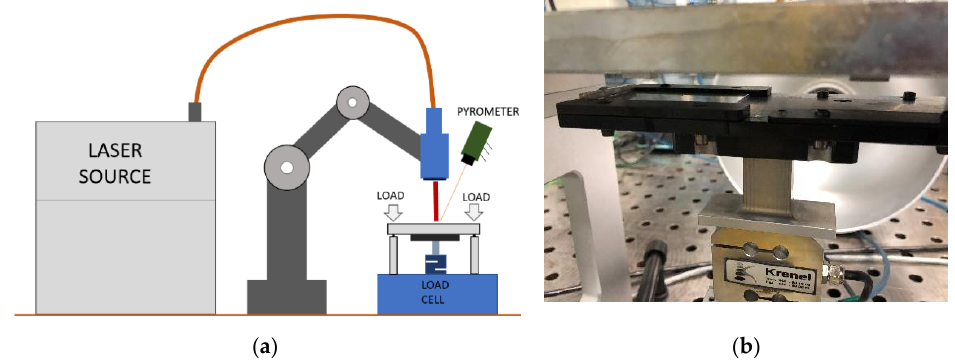
Figure 5. ( a ) Joining set-up description. ( b ) Pressure tool details.